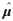
Time-evolution of departments μ^.Each circle and bar represent, respectively, the μ^ and σ^ for a given year of publications. We estimate the parameters in Eq (1) for sets of departmental publications using a “sliding window” of 3 years. Fits for which we cannot reject the hypothesis that the data is consistent with a discrete lognormal distribution are colored green. We also show each department’s average value of μ^ over the period considered (orange dashed lines).